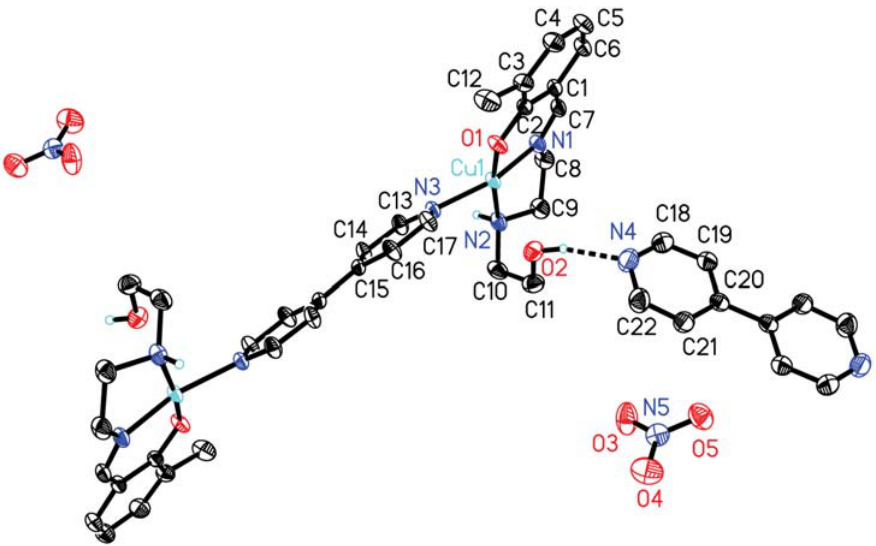
Figure 1. The structure of the complex, showing the atom-numbering scheme. Displacement ellipsoids are drawn at the 30% probability level. Un- labelled atoms are at the symmetry position (2 – x , 1 – y , – z ).